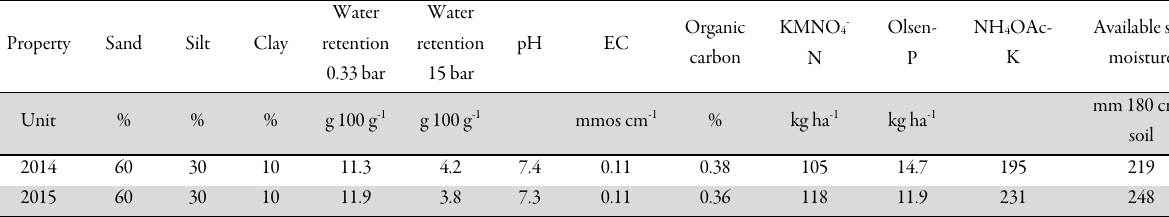
Table 1. Some physical and chemical characteristics of the experimental soil Property Sand Silt Clay